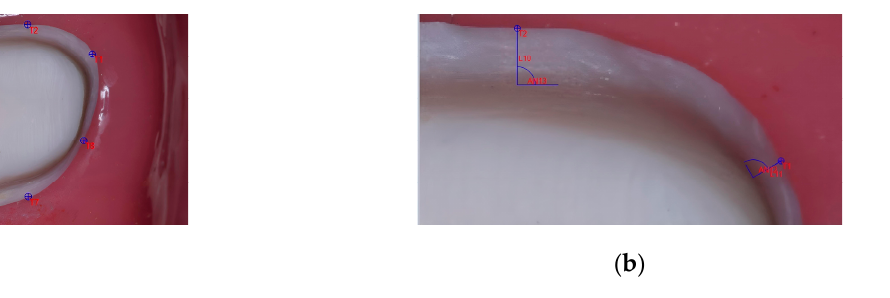
Figure 2. The measurements with the Image ‐ Pro Insight software: ( a ) The eight reference points; ( b ) Measurements of the width of the chamfer at the reference points.